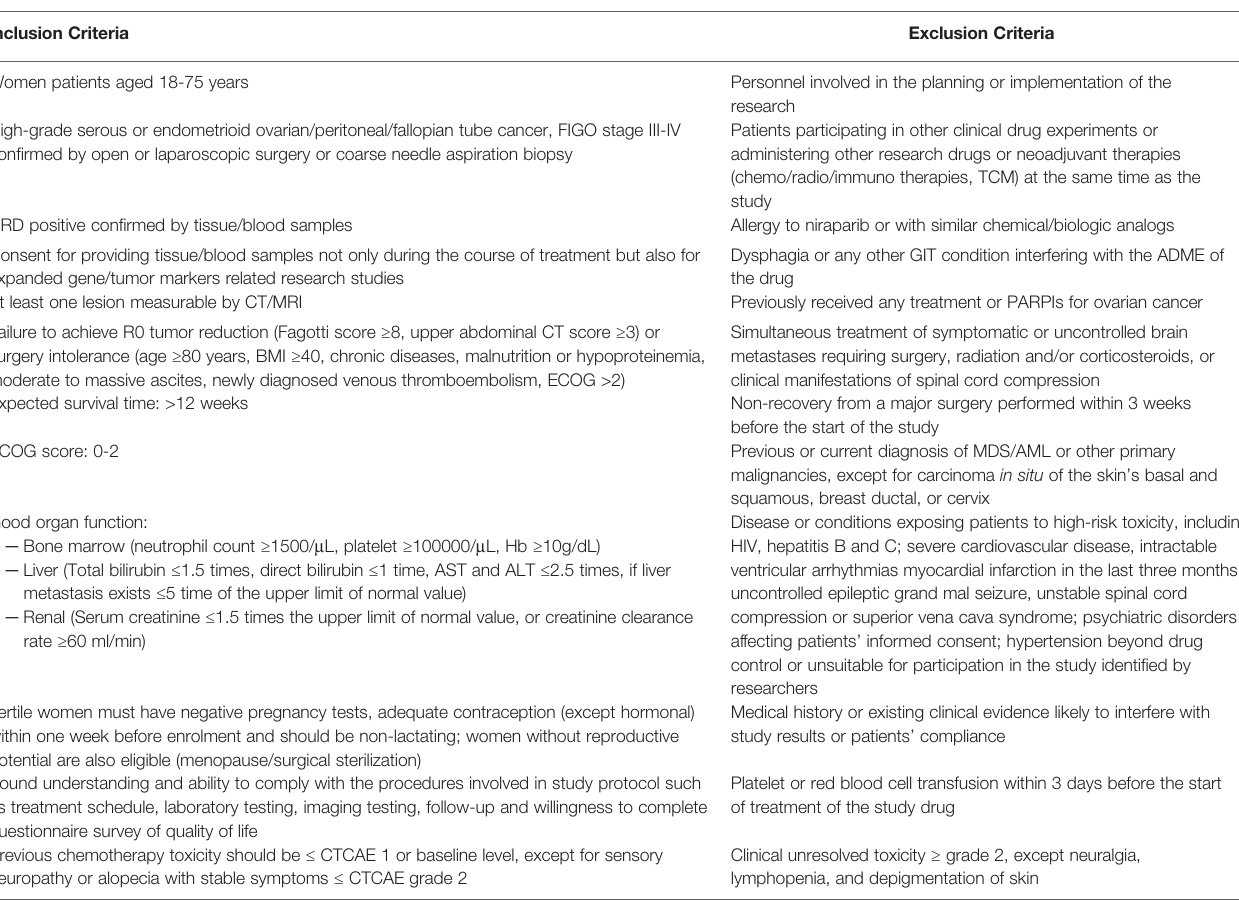
TABLE 1 | Key inclusion and exclusion